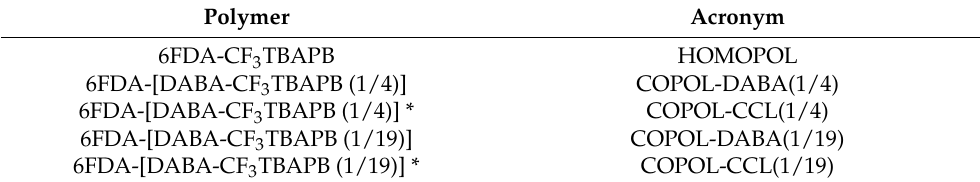
Table 1. Acronyms of polymers.